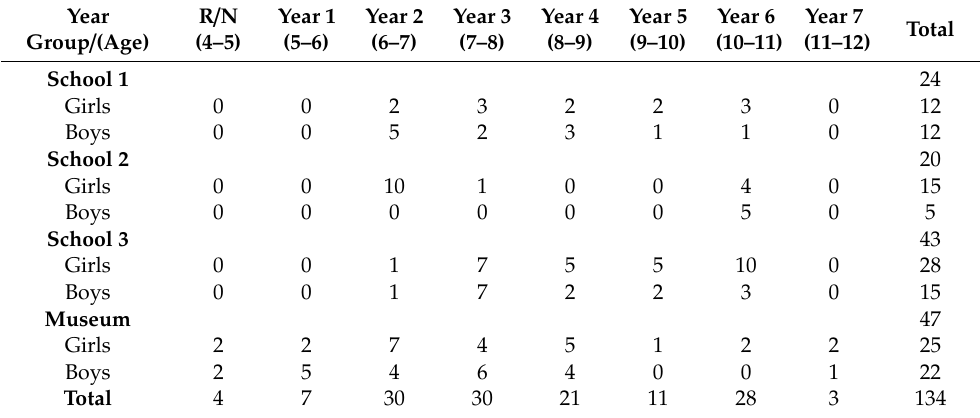
Table 6. Participant sample design